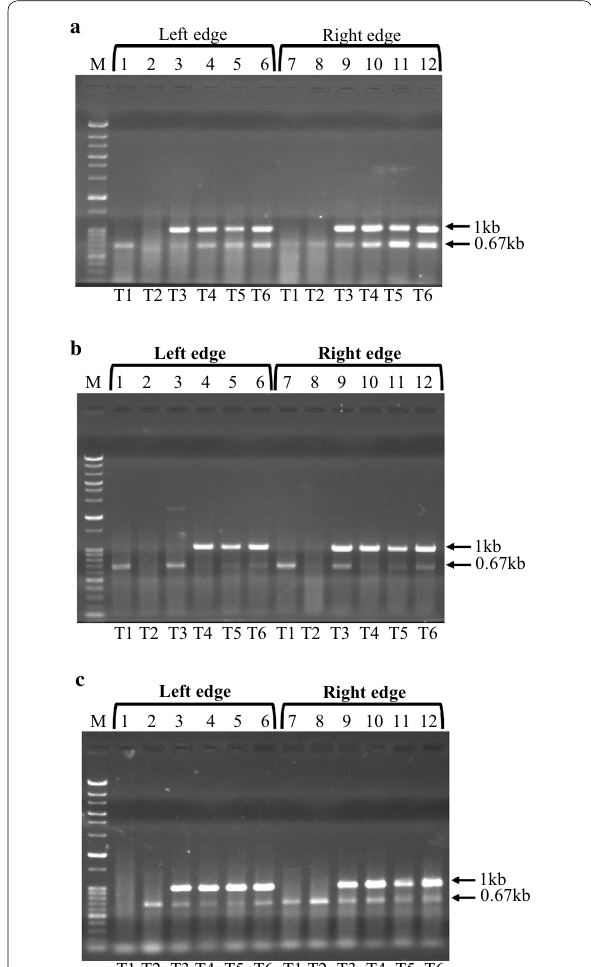
Fig. 3 Colony PCR analysis of replaced Chr2-2, Chr9-2 and Chr11-2 regions. Each lane represents checking of left or right edge replacement of entire Chr2-2, Chr9-2 and Chr11-2 regions in independent transformants (T1, T2, T3, T4, T5 and T6), respectively. 1 kb band was the expected band for replacement of either left or right edge of entire regions. a SJP 217 and SJP 119 were used for checking left edge whereas SJP 127 and SJP 383 were used for checking right edge replacement of Chr2-2 region, respectively. b SJP 215 and SJP 119 were used for checking left edge whereas SJP 127 and SJP 369 were used for checking right edge replacement of Chr9-2 region, respectively. c SJP 219 and SJP 119 were used for checking left edge whereas SJP 127 and SJP 387 were used for checking right edge replacement of Chr11-2 region,